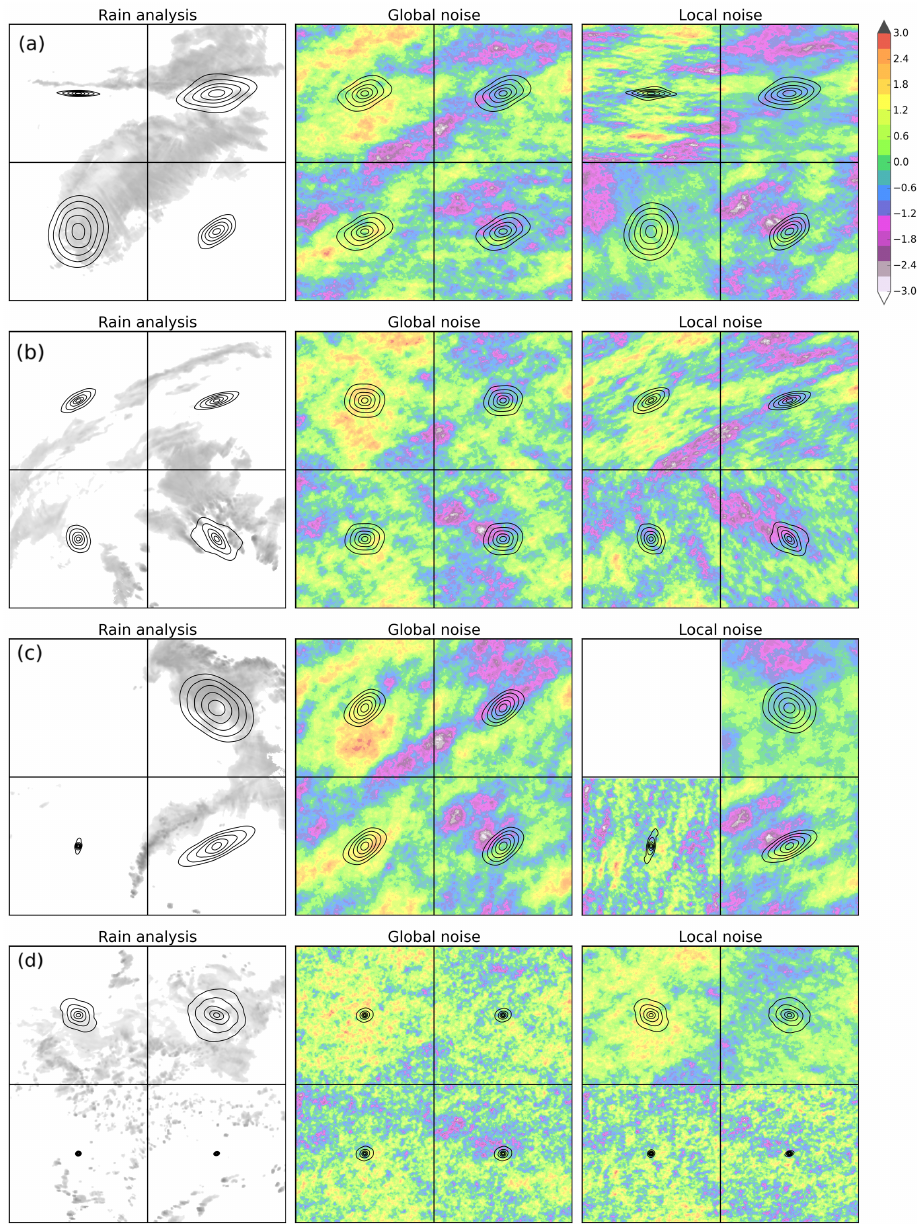
Figure 10. Localised 2-D autocorrelation functions (black contours for 0.5, 0.6, 0.7, 0.8 and 0.9 correlation coefficients) for all four case studies (rain rates in black and white) and the corresponding non-parametric stochastic simulations using both the global and local generators. The image domain is 512km × 512km. All noise fields have been drawn from the standard normal distribution and share the same random